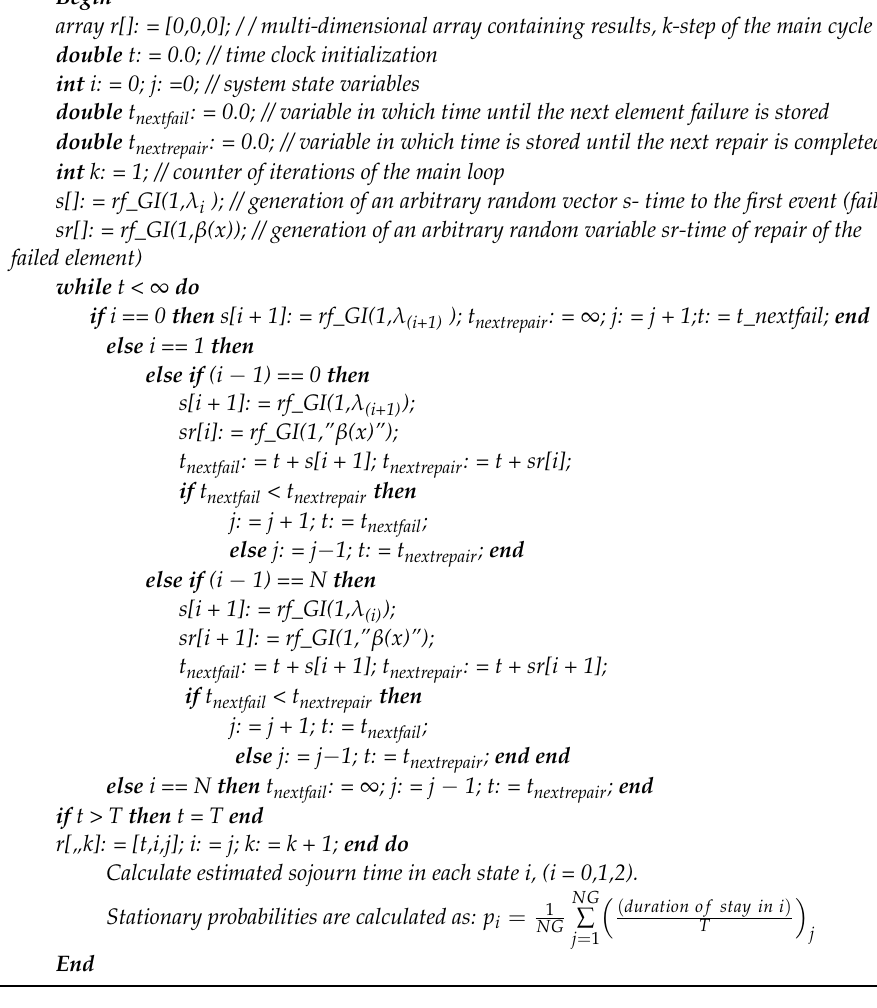
Algorithm A1 . The simulation pseudocode for the system < GI 2 / GI